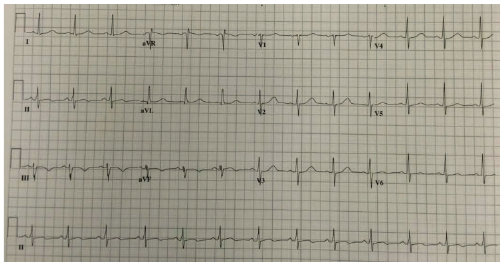
decrease risk of bleeding from antiplatelets given for PCI. The second catheterization (Figures 3(a), 3(b), and 3(c)) showed normal